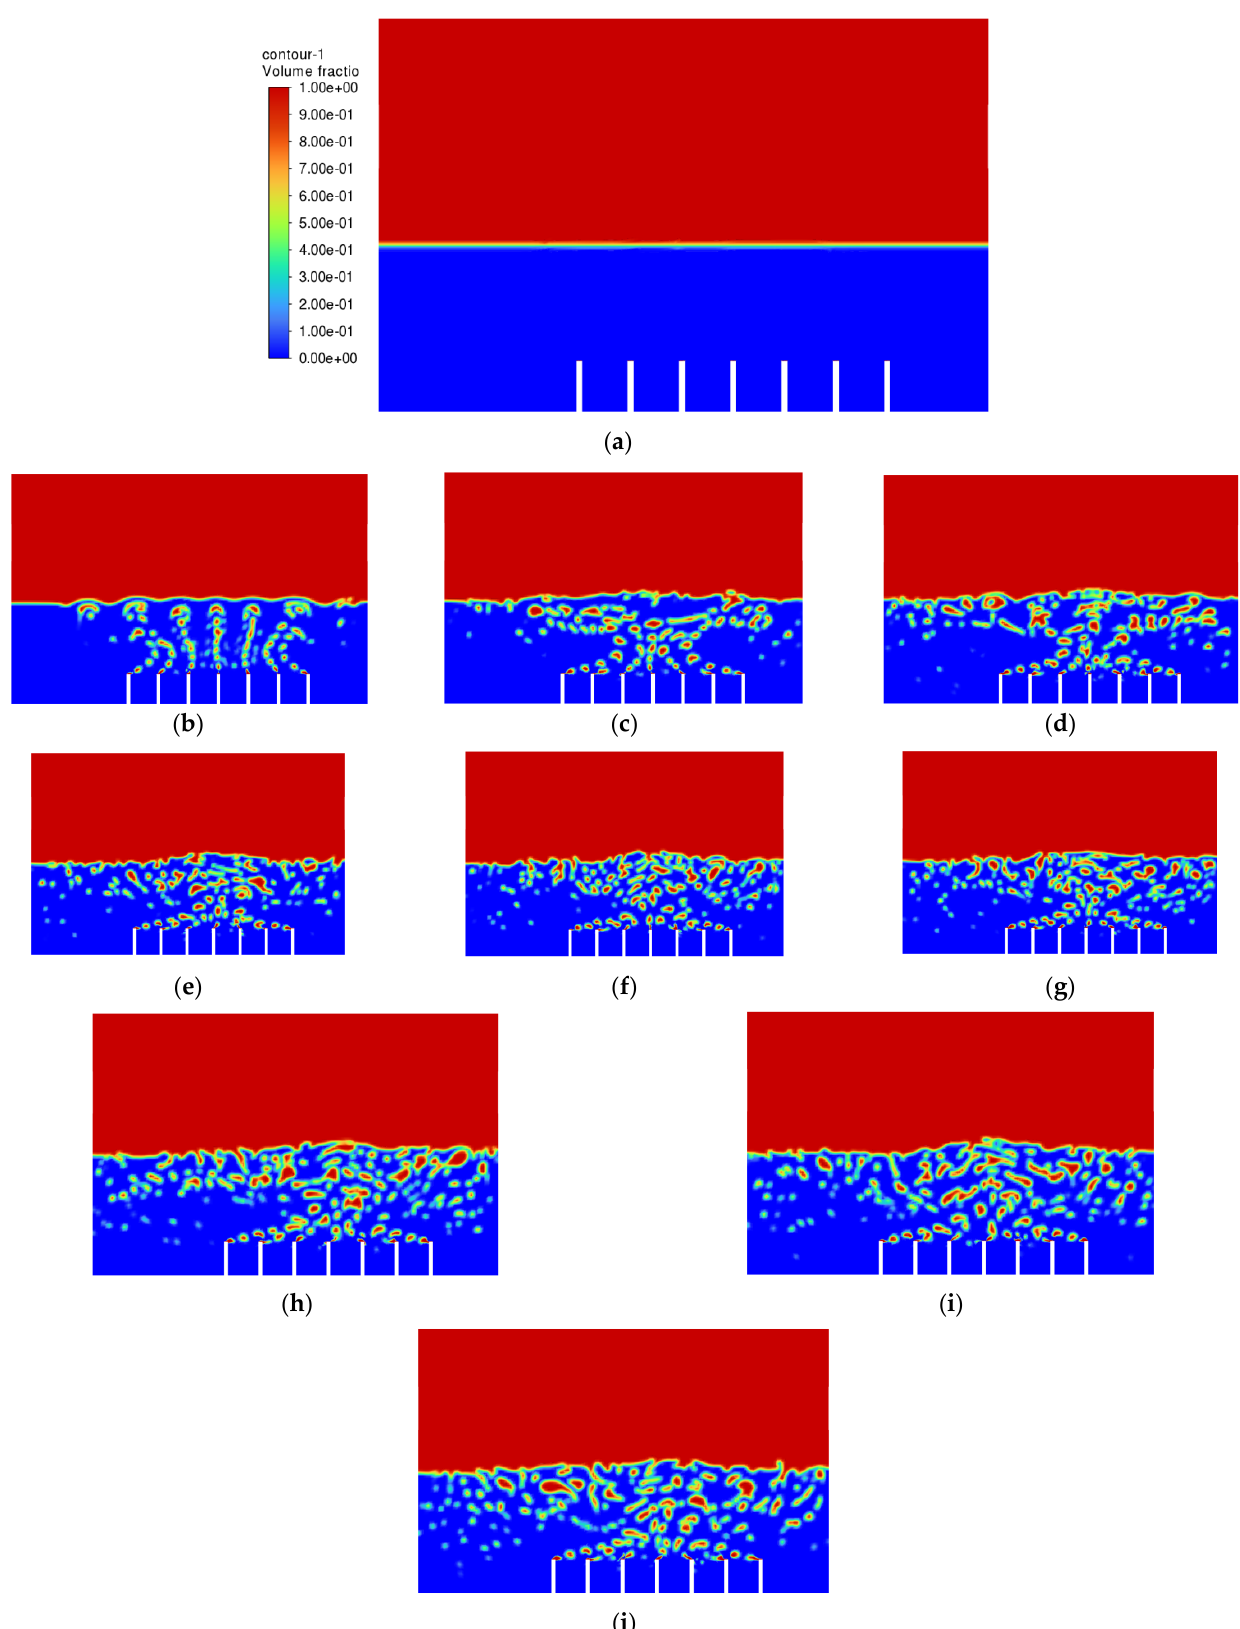
Figure 6. Air-phase contour of Simulation 2: ( a ) 0.0 s; ( b ) 0.5 s; ( c ) 1.0 s; ( d ) 1.5 s; ( e ) 2.0 s; ( f ) 2.5 s; ( g ) 3.0 s; ( h ) 3.5 s; ( i ) 4.0 s; ( j ) 4.5